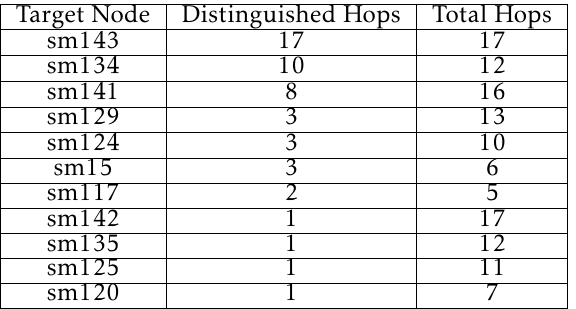
Table 1. Path priority decision applying algorithm 1 Target Node